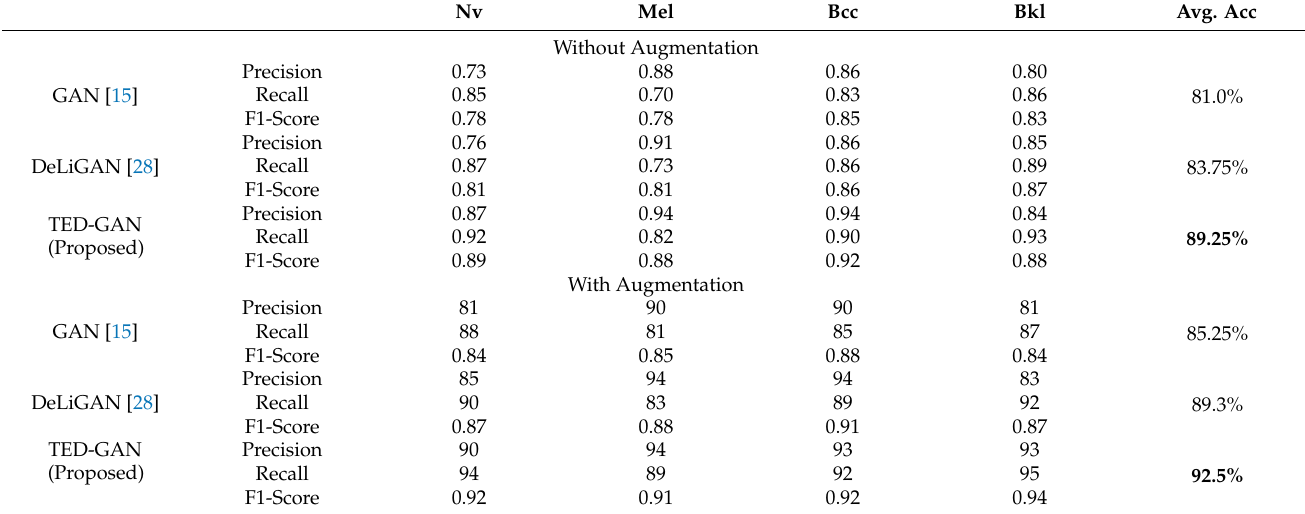
Avg. Acc = average accuracy; Bold indicates the maximum value achieved in the respective experiment